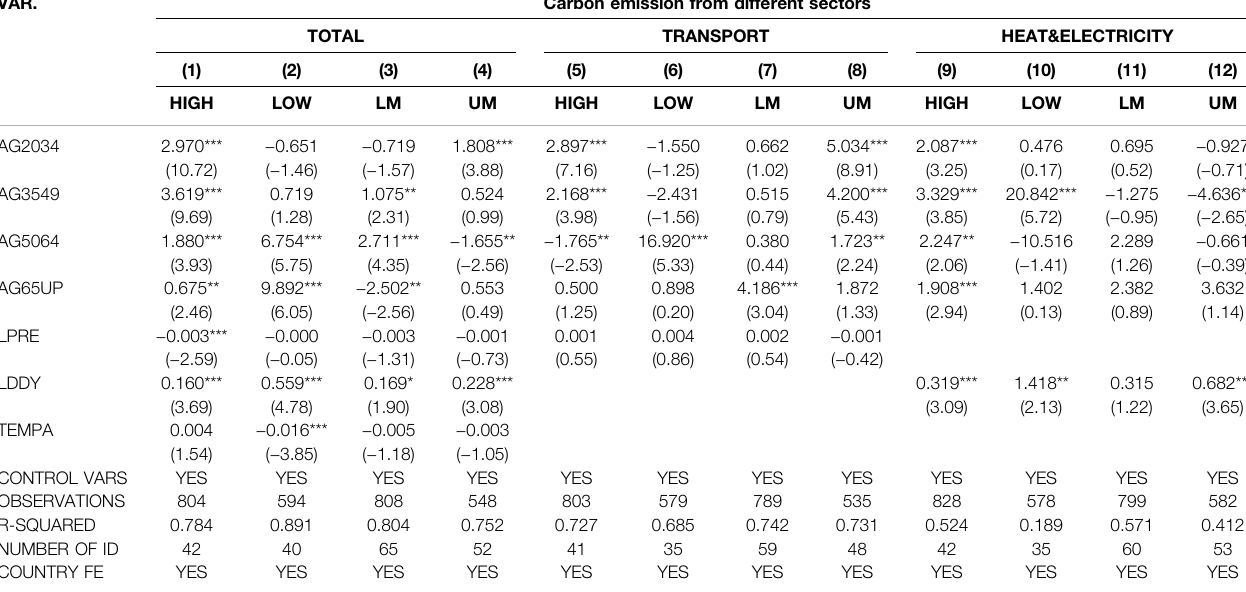
TABLE 7 | Sample group divided by World Bank income level standard VAR.